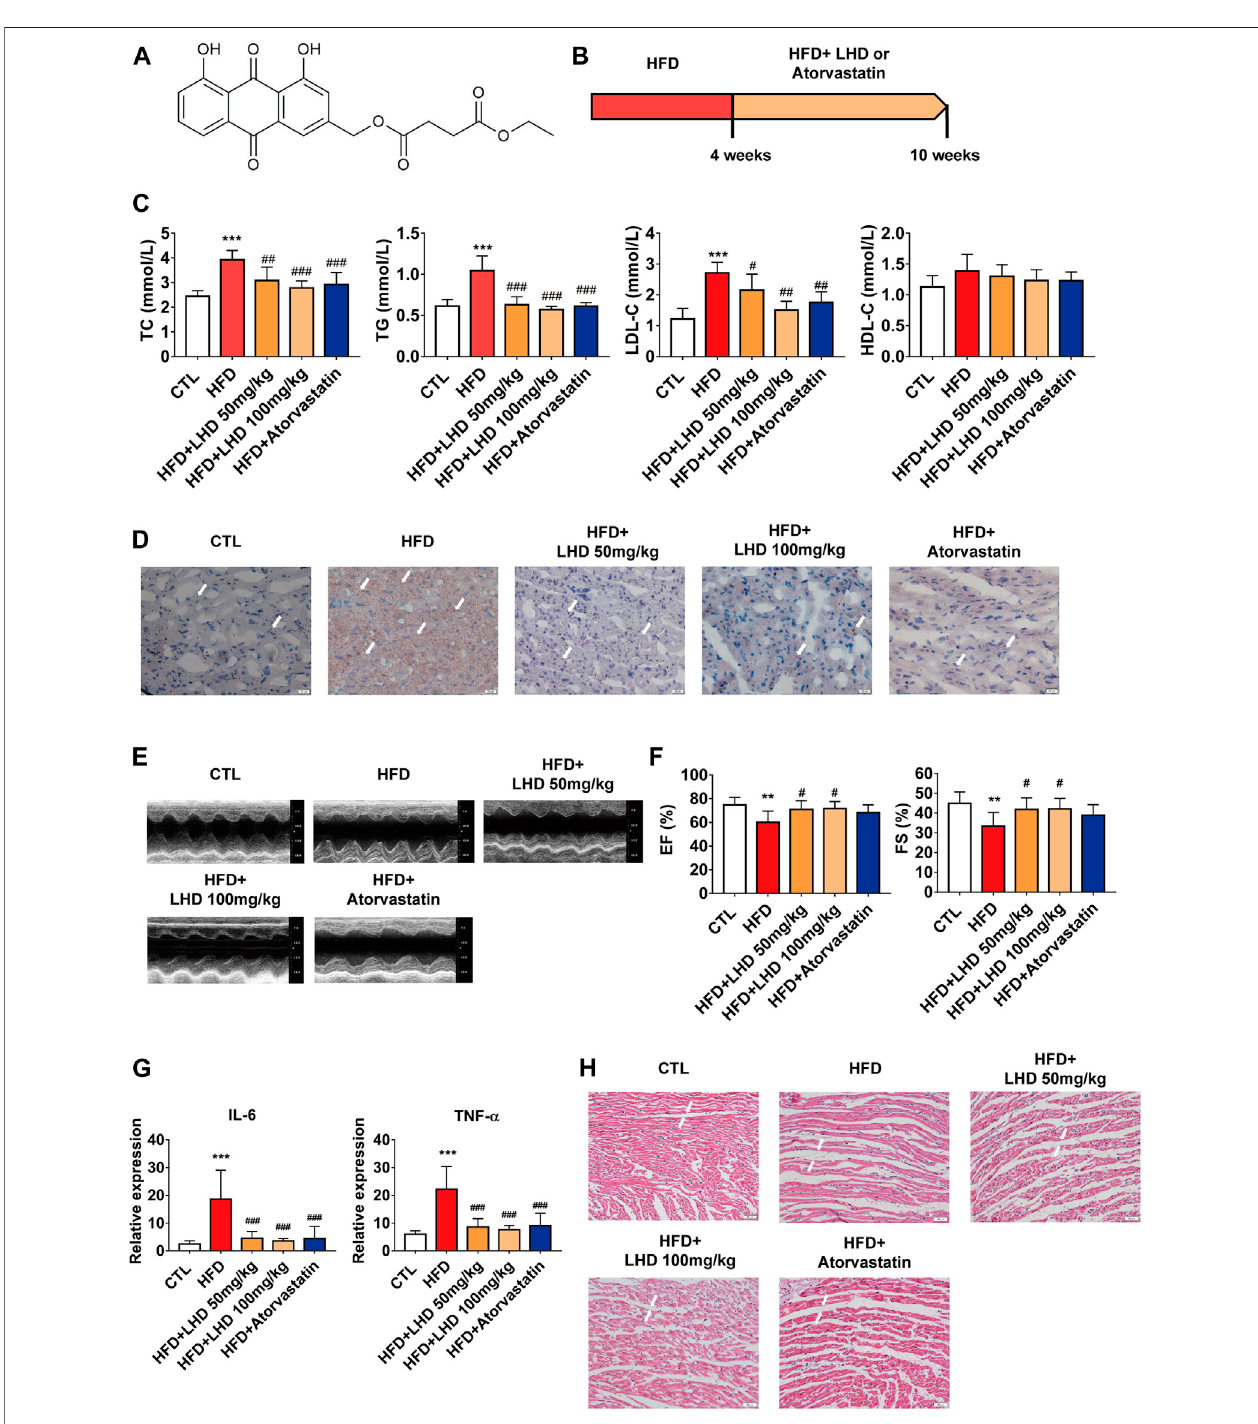
FIGURE1| LHDprotectsagainsthyperlipidemia-inducedcardiacdysfunction. (A) ChemicalstructureofLHD. (B) Wistarratfeedingschedule. (C) Measurementof TC, TG, LDL-C, and HDL-C in the serum of rats fed a high-fat diet (HFD) for 10 weeks. *** p < 0.001, compared with the CTL group; # p < 0.05, ## p < 0.01, ### p < 0.001, comparedwiththeHFDgroup, n (cid:1) 8. (D) OilRedOstainingtoidentifylipiddepositionincardiactissue(10 × magni fi cation). n (cid:1) 4. (E,F) Echocardiographicanalysisofleft ventricular ejection fraction (EF%) and left ventricular shortening fraction (FS%) in rats fed with HFD for 10 weeks. ** p < 0.01, compared with the CTL group; # p < 0.05,compared withtheHFDgroup, n (cid:1) 8. (G) ELISAanalysisofIL-6andTNF- α intheserum.*** p < 0.001,compared withtheCTLgroup; ### p < 0.001,comparedwith the HFD group. n (cid:1) 8. (H) H&E staining to identify in fi ltrative in fl ammation in cardiac tissue (10 × magni fi cation), n (cid:1) 4.